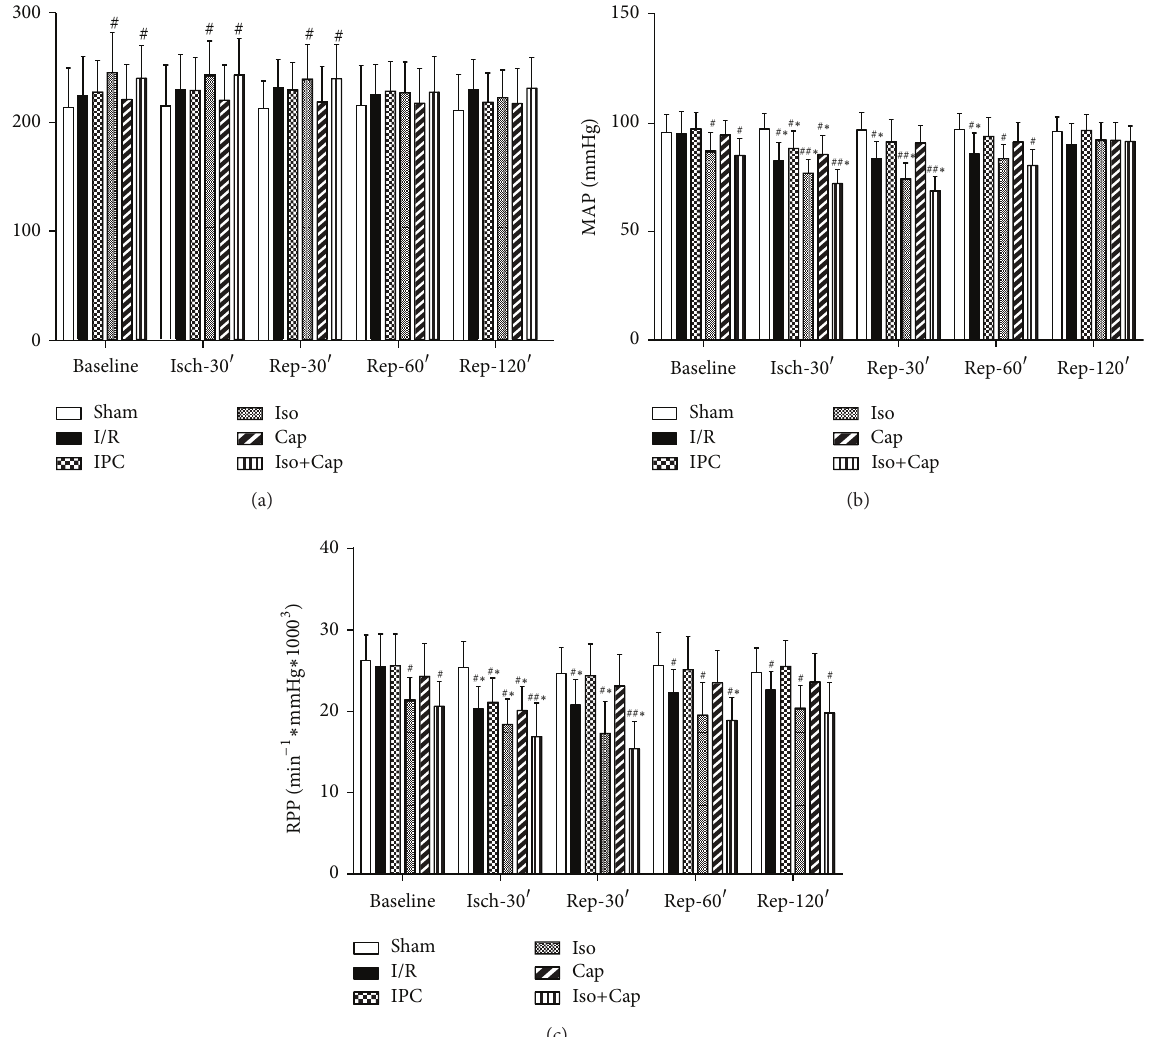
Figure 4: Isoflurane (Iso) and captopril (Cap) improved postischemic myocardial function recovery in rabbits. (a) Heart rate, (b) mean arterial pressure (MAP), and (c) rate pressure product (RPP) at baseline and during ischemia and reperfusion. Sham: sham operated control; I/R: rabbits subjected to myocardial ischemia reperfusion (MI/R); Cap: rabbits treated with captopril (25 mg/kg given intravenously 24 h) prior to inducing MI/R; Iso: rabbits received isoflurane preconditioning (15min 1.1% end tidal isoflurane followed by a 15min washout period before inducing MI/R); Iso+Cap: rabbits received captopril in combination with Iso. Data are shown as means ± SD, with 𝑛 = 8 animals per group. # 𝑃 < 0.05 or 𝑃 < 0.01 versus Sham, ∗ 𝑃 < 0.05 versus Baseline.